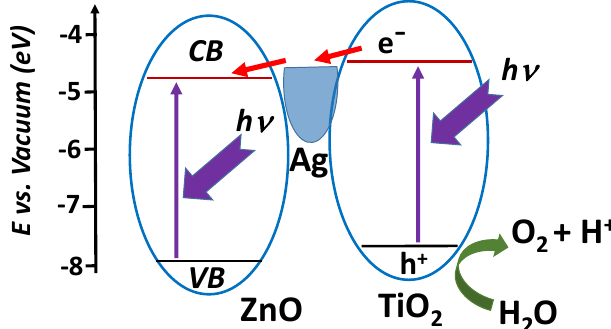
Figure 9. The energy levels of ZnO, Ag NP, and TiO 2 in the ZAT heterostructure, and the schematics of carrier generation, separation, and OER in TiO 2 in PEC water splitting. The energy levels of ZnO are pulled down more than those of other components by the positive bias voltage in the PEC